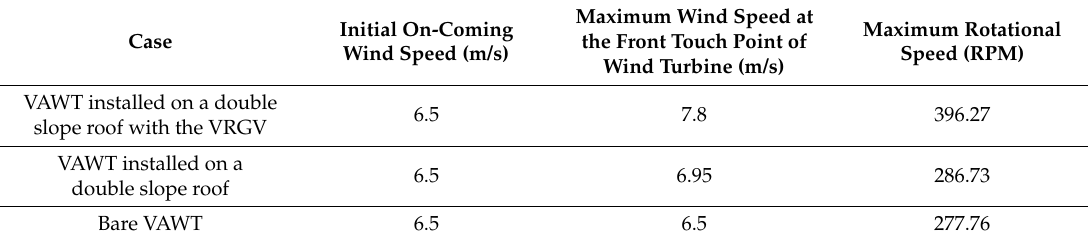
Figure 20. Rotational speed comparison between the open rotor VAWT, VAWT with double slope roof, VAWT with double slope roof and VRGV at initial wind speed of 6.5 m/s. Table 14. Performance comparison in the experiment without